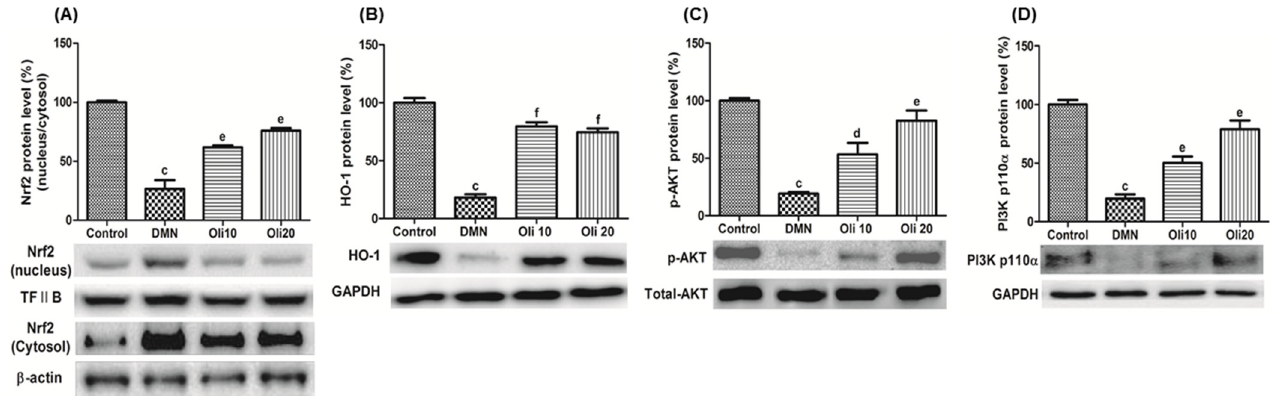
Figure 7. Effects of oligonol on Nrf2 activation ( A ), HO-1 production ( B ), and PI3K ( C ) and Akt activation ( D ) in DMN- intoxicated rat liver. Western blotting was performed to detect these protein levels and quantified by image analysis. The relative level of Nrf2 in the nuclear and cytosol compared with TFIIB and β -actin, respectively. The band intensity of phosphorylated Akt was normalized to total Akt. Values are mean ± SE ( n = 3). c p < 0.001 vs. the control group, and d p < 0.05, e p < 0.01, and f p < 0.001 vs. the DMN group.